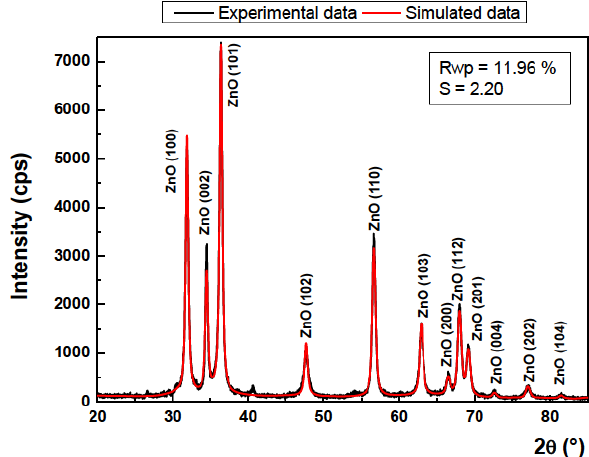
Figure 3: XRD pattern of ZnO-1.4wt% Graphene hybrid sonochemi- cally prepared at pH= 8.5, after drying at 150 ∘ C. Red curve stands for the simulated data using Rietveld